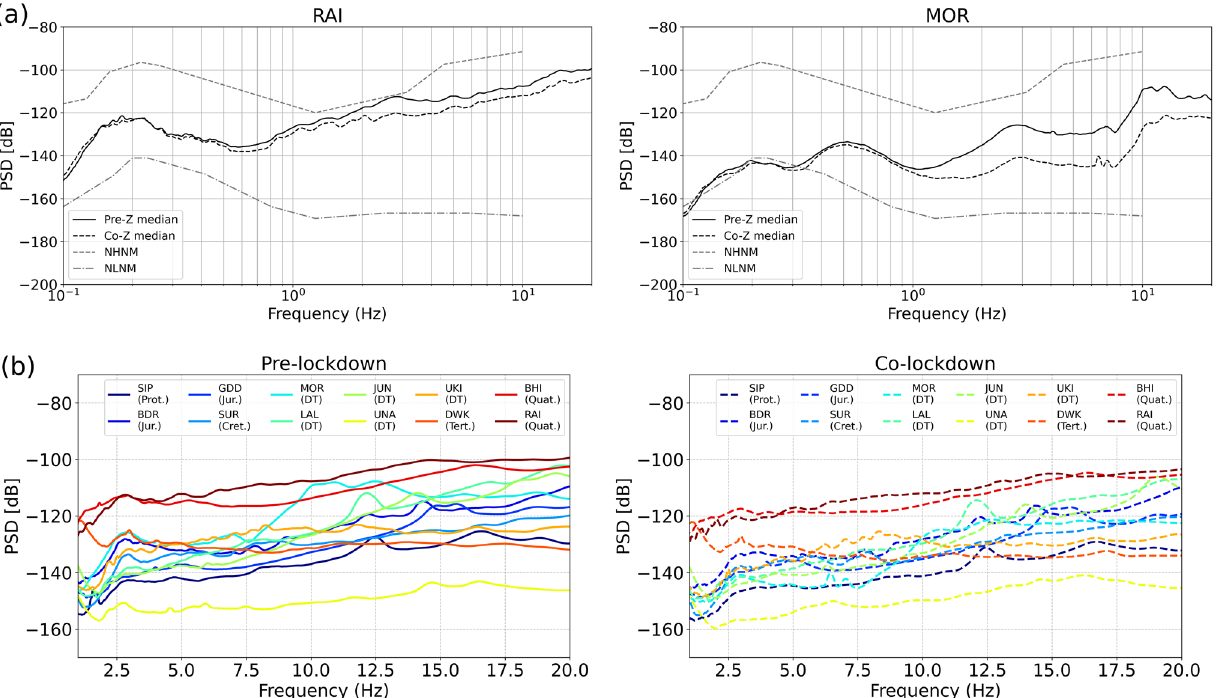
Figure 2. Seismic background noise levels with respect to frequency before and during the lockdown in terms of PSD using median values. ( a ) The variation in PSD value in terms of median for the vertical (Z) component is shown for the pre- and co-lockdown periods in the frequency range of 0.1–20 Hz, that is representative of ambient and anthropogenic noise for two different stations (MOR, RAI) of ISR seismic network. PSD variation for other stations is shown in supplementary Figure S6. The new high and new low noise models (NHNM, NLNM) 9 are represented by gray lines, as upper and lower limits. ( b ) Comparison of PSD in the high frequency Proterozoic rocks (SIP), Jurassic rocks (BDR, GDD), Cretaceous rocks (SUR), Deccan Traps (MOR, LAL, JUN, UNA, UKI), Tertiary sediments (DWK), and Quaternary sediments (BHI, RAI). Local